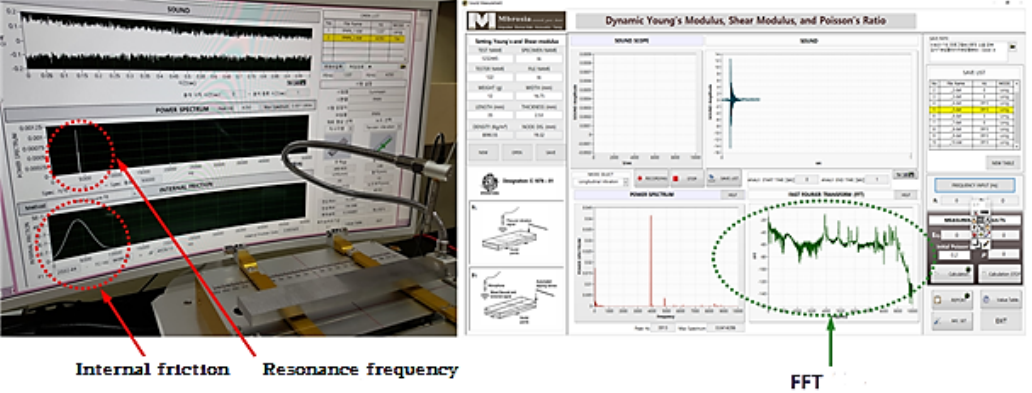
Figure 5. Setup for dynamic Young’s modulus